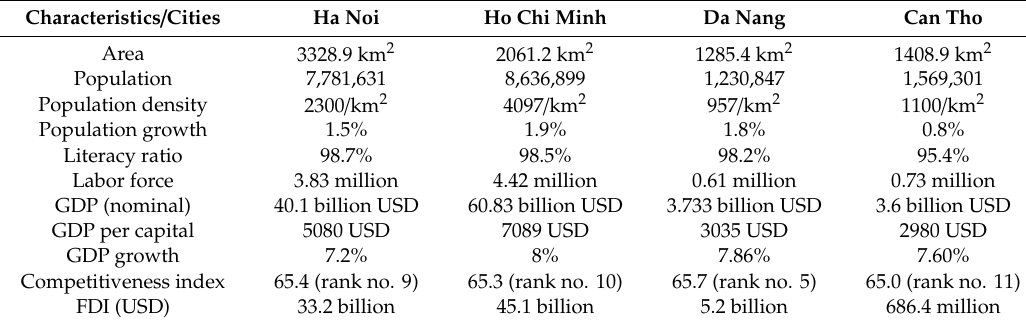
Table 2. Descriptive statistics of major cities in Vietnam (2018).